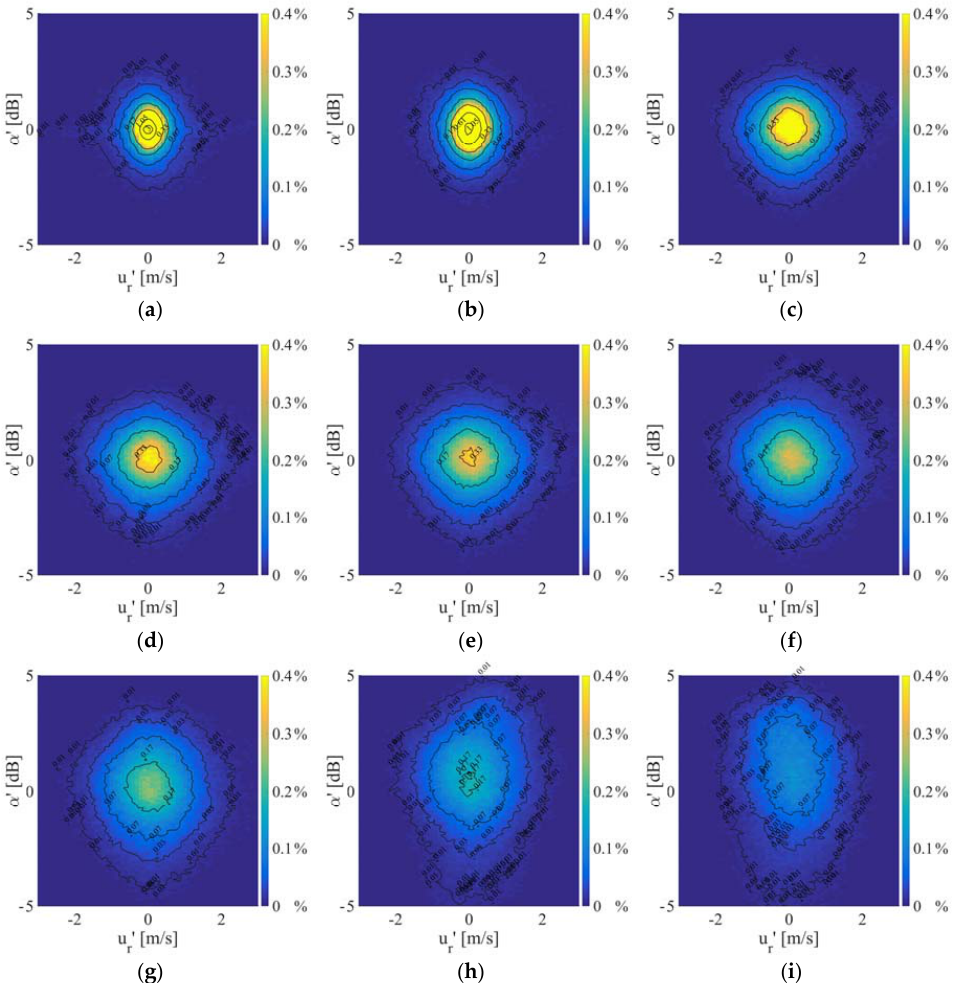
Figure 4. Visualisation of different normalisation times ∆(cid:1872) of the LiDAR data distribution in the normalised frame of reference ( a ) ∆(cid:1872) = 0.5 s, ( b ) ∆(cid:1872) = 1 s, ( c ) ∆(cid:1872) = 5 s, ( d ) ∆(cid:1872) = 15 s, ( e ) ∆(cid:1872) = 30 s, ( f ) ∆(cid:1872) = 60 s, ( g ) ∆(cid:1872) = 120 s, ( h ) ∆(cid:1872) = 300 s, ( i ) ∆(cid:1872) = 600 s . The influence of normalisation for different ∆(cid:1872) to the data density can be taken from Figure 4.